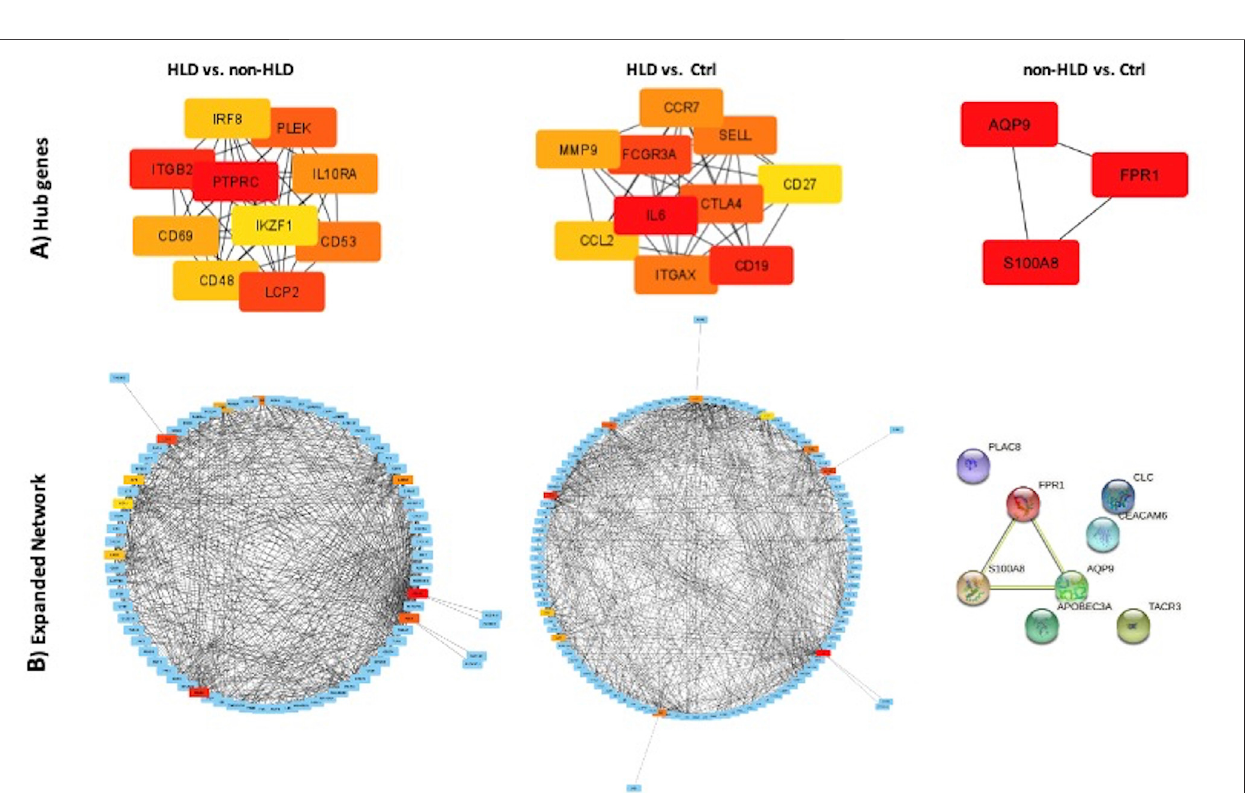
FIGURE 3 | PPI network of common genes and hub genes were identi fi ed using Cytoscape and cytoHubba plug-in, respectively, for HLD vs. non-HLD, HLD vs. Ctrl, and non-HLD vs. Ctrl subgroup analysis. (A) Hub genes are colored from yellow to red, with red being the most important. (B) Expanded network with fi rst-stage nodes of hub genes; from yellow to red color indicating higher importance for red hub genes; and blue nodes represent DEGs.